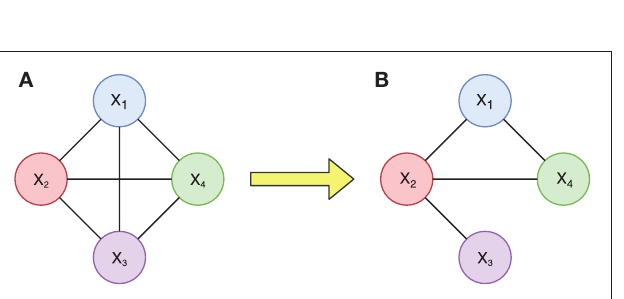
FIGURE 2 | Changes of a connection diagram with 4 nodes. (A) Candidate connection diagram with four nodes. (B) Limited connection diagram with only four corresponding connections.